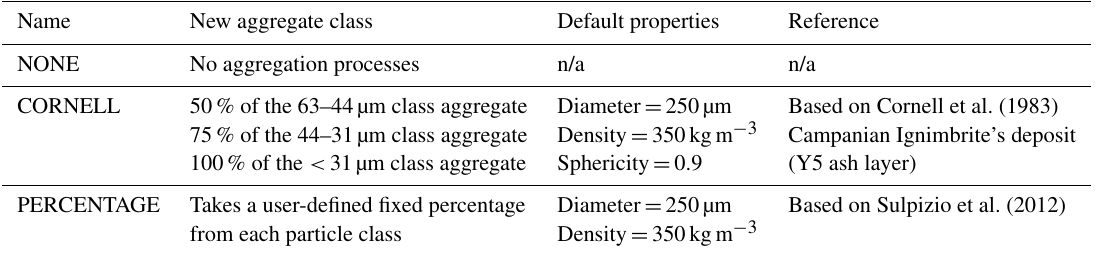
Table 3. Ash aggregation options in NMMB-MONARCH-ASH from analytical solutions based on field observations. Default aggregate properties can be modified by the user. n/a = not